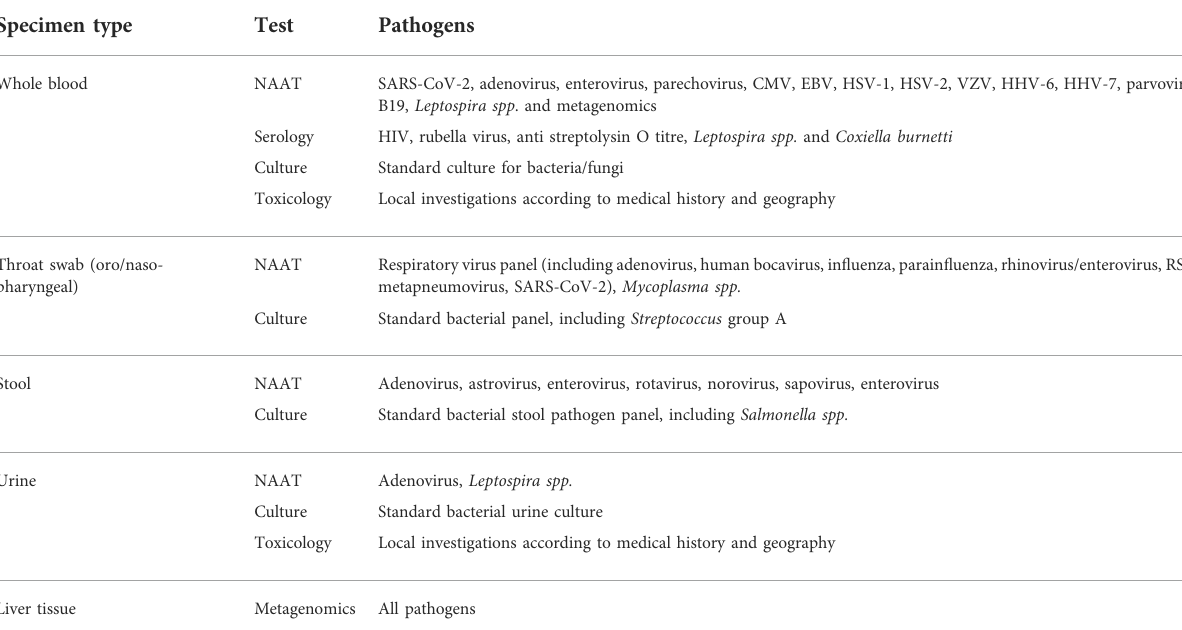
TABLE 2 Specimen collection and suggested investigative diagnostics (adapted from https://www.who.int/publications/i/item/who-unkhep- laboratory-2022.1). SARS-CoV-2: Severe acute respiratory syndrome coronavirus-2; CMV = cytomegalovirus; EBV = Epstein-Barr virus; HSV-1 and 2 = herpes simplex virus type 1 and 2; VZV = varicella-zoster virus; HHV-6 and 7 = human herpesvirus 6 and 7; RSV = respiratory syncytial virus; NAAT = nucleic acid ampli fi cation test. Specimen